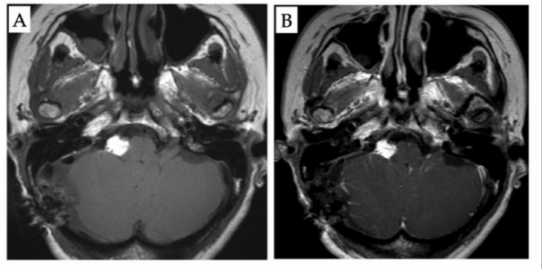
Figure 3. Post-operative magnetic resonance imaging (MRI) findings. ( A ): Non-contrast axial T1- weighted MRI. ( B ): Contrast T1-weighted MRI showing no residual